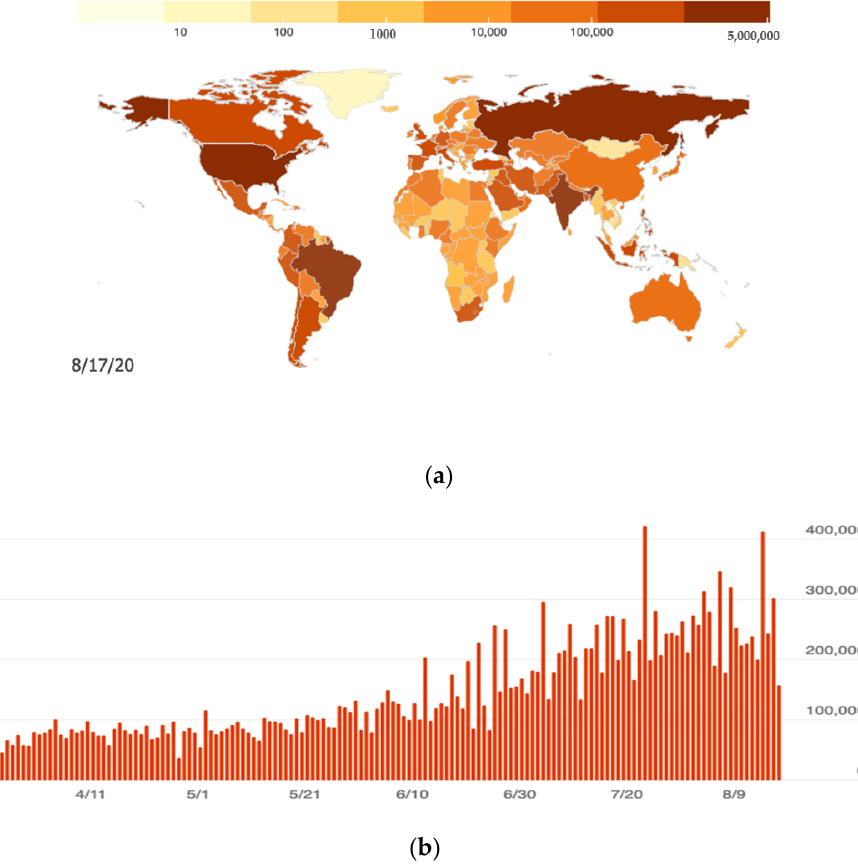
Figure 2. Global confirmed cases of the COVID-19 pandemic [14]. ( a ) COVID-19 pandemic across the globe; ( b ) Global daily new cases of the COVID-19 [14].